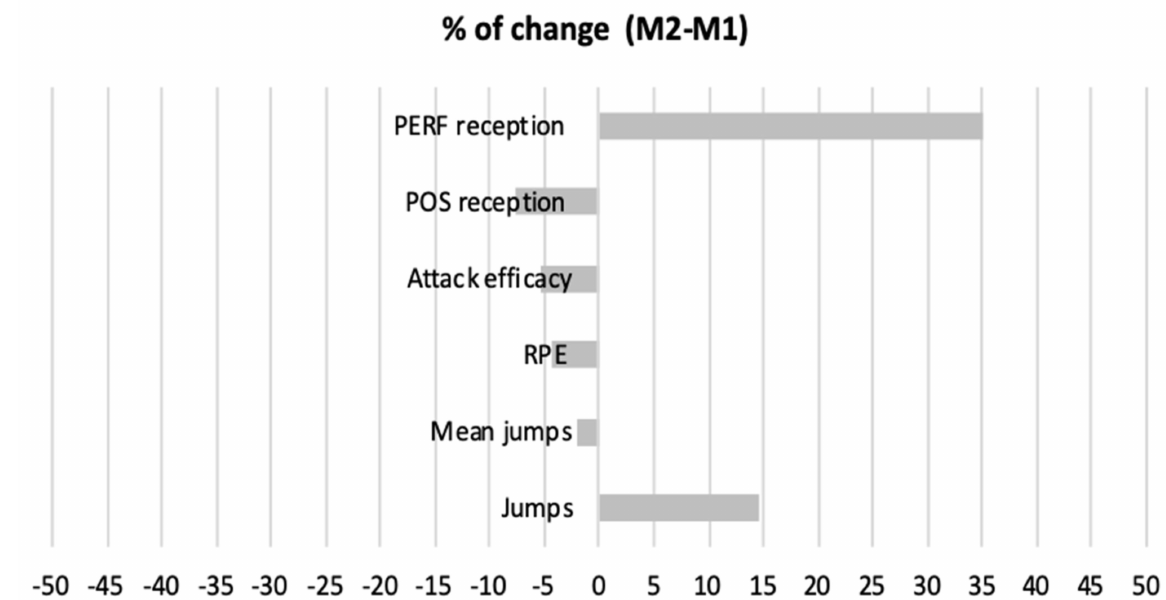
Figure 2. Percentage of change (M2-M1) for the different outcomes. M1—match 1; M2—match 2; POS—positive; PERF— perfect; RPE—rate of perceived